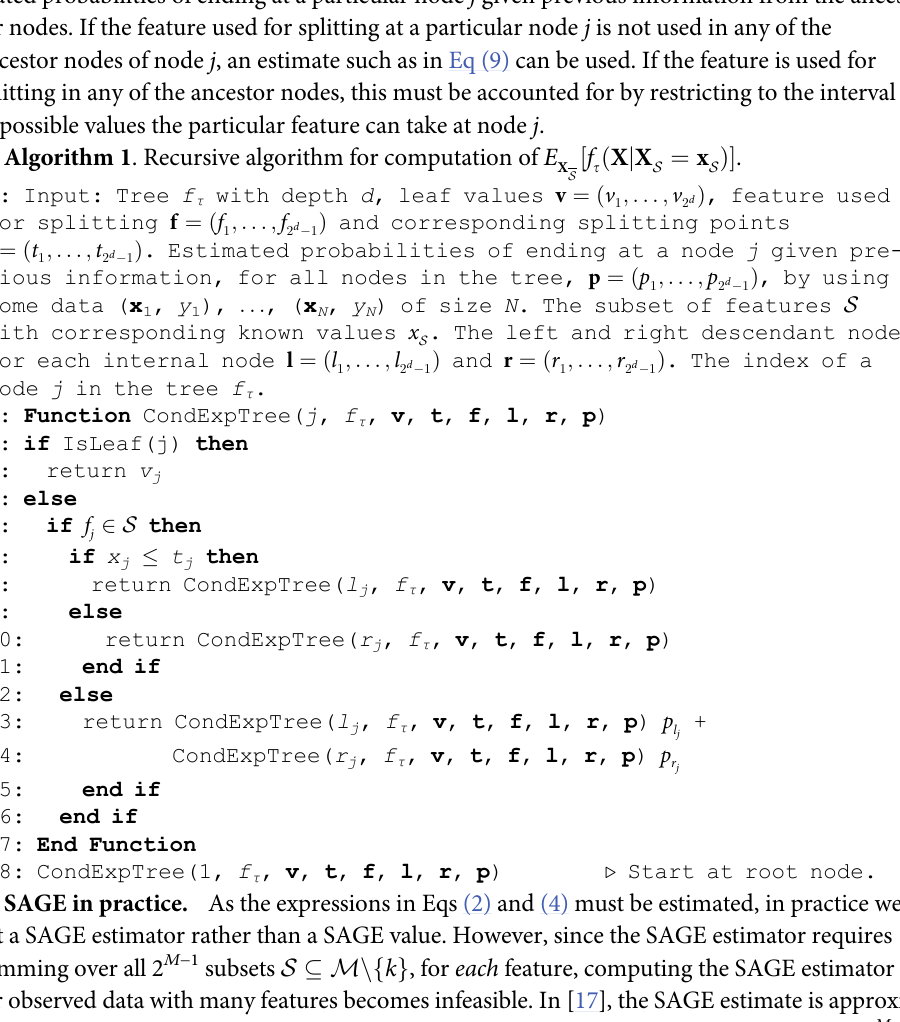
½ f ð X j X ¼ x Þ� t S S X S